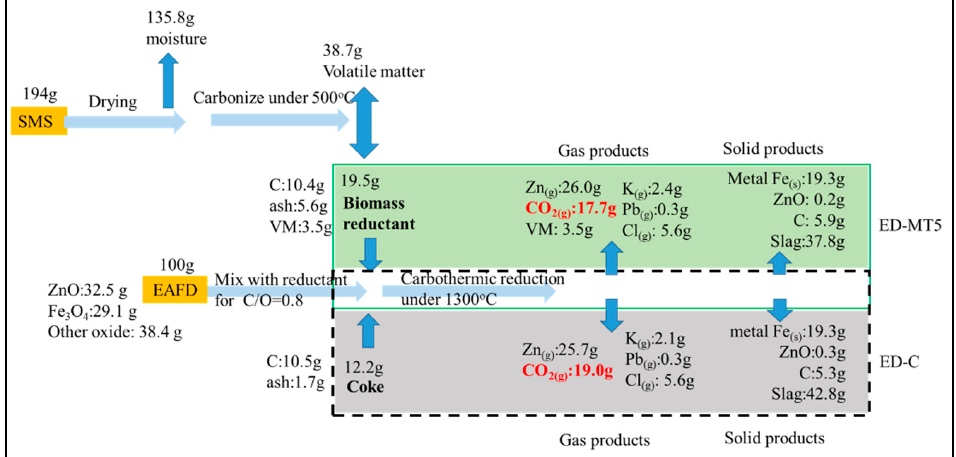
Figure 5. Material flow analysis of ED-MT5 and ED-C as EAFD reducing agents (C/O = 0.8, 1300 °C) and their effects on carbon emissions. Under almost the same Zn products, biomass samples produced less CO 2 than coke samples. Besides, the biomass reductant showed the potential for extra carbon-reducing according to the assumption of carbon neutrality. Taiwan needs to process 120,000 tons of EAFD annually. If this method is adopted, 23,000 tons of CO 2 emissions will be reduced, creating a channel to process 230,000 tons of SMS annually.